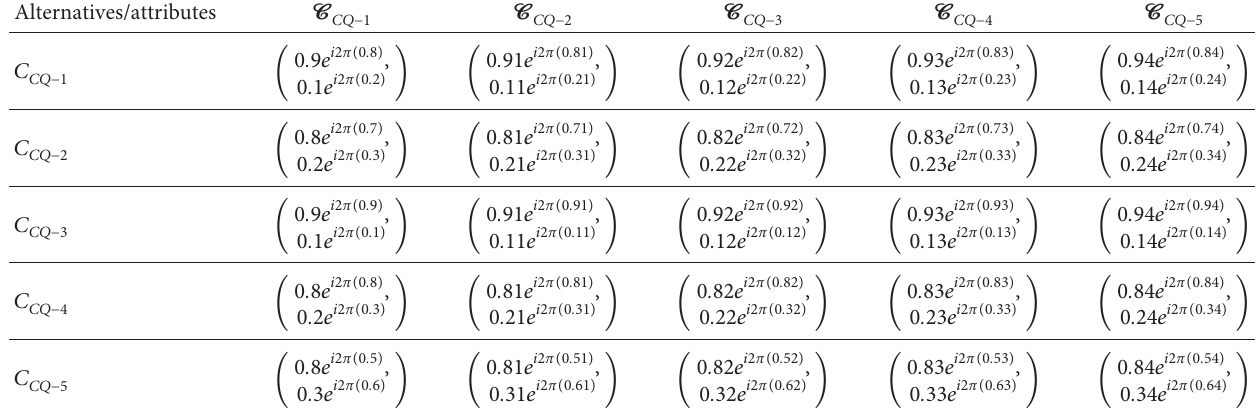
Table 3: Rating values of the alternatives in terms of CPFNs for Example 2.